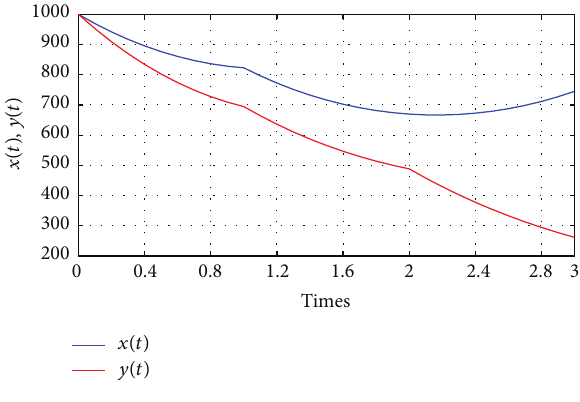
Figure 1: Time behavior for state variables 𝑥(𝑡) and 𝑦(𝑡) with the optimal strategies 𝑢 ∗ , V ∗